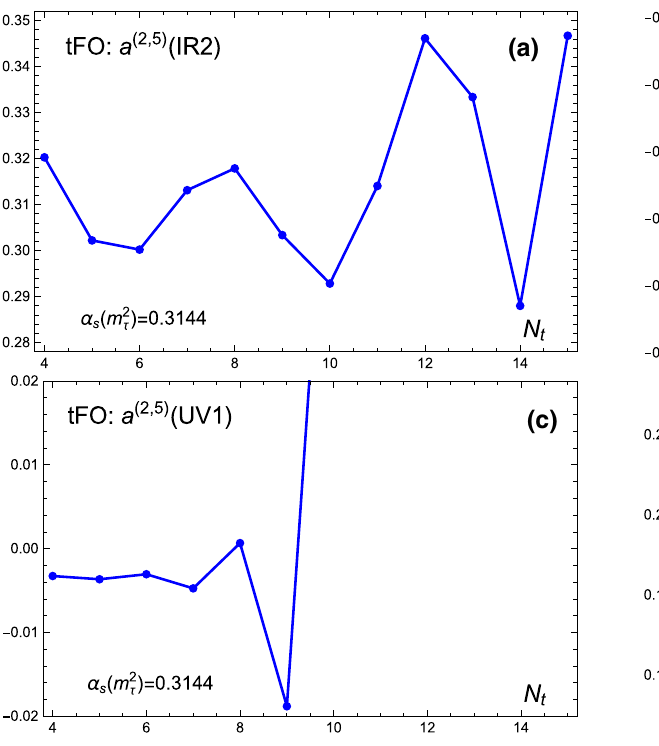
Fig. 4 As in Fig. 3, but now for the (cid:2) FOPT (’tFO’) approach